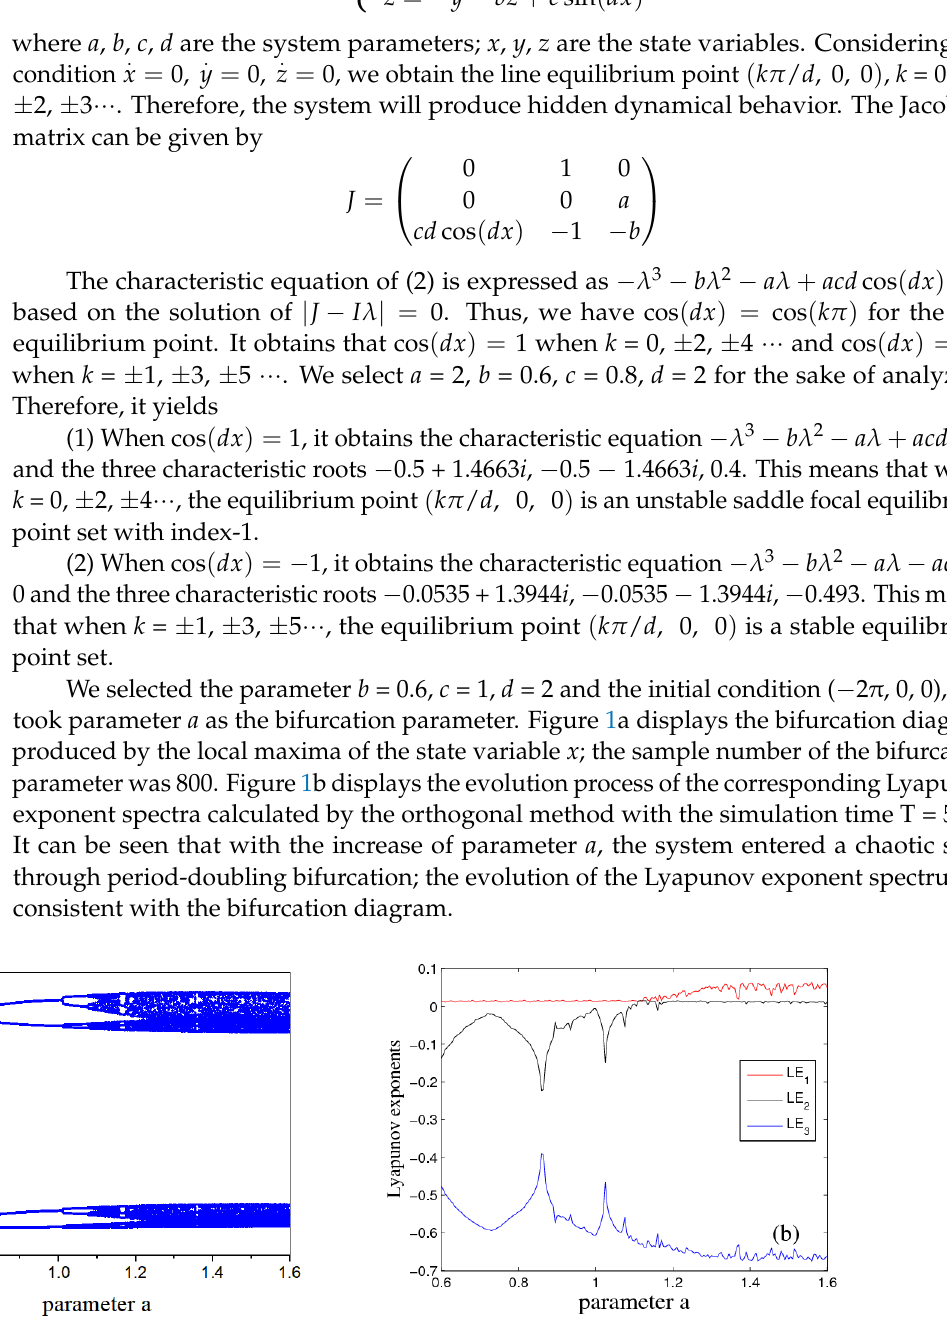
Figure 1. ( a ) Bifurcation diagram and ( b ) Lyapunov exponent spectra versus a